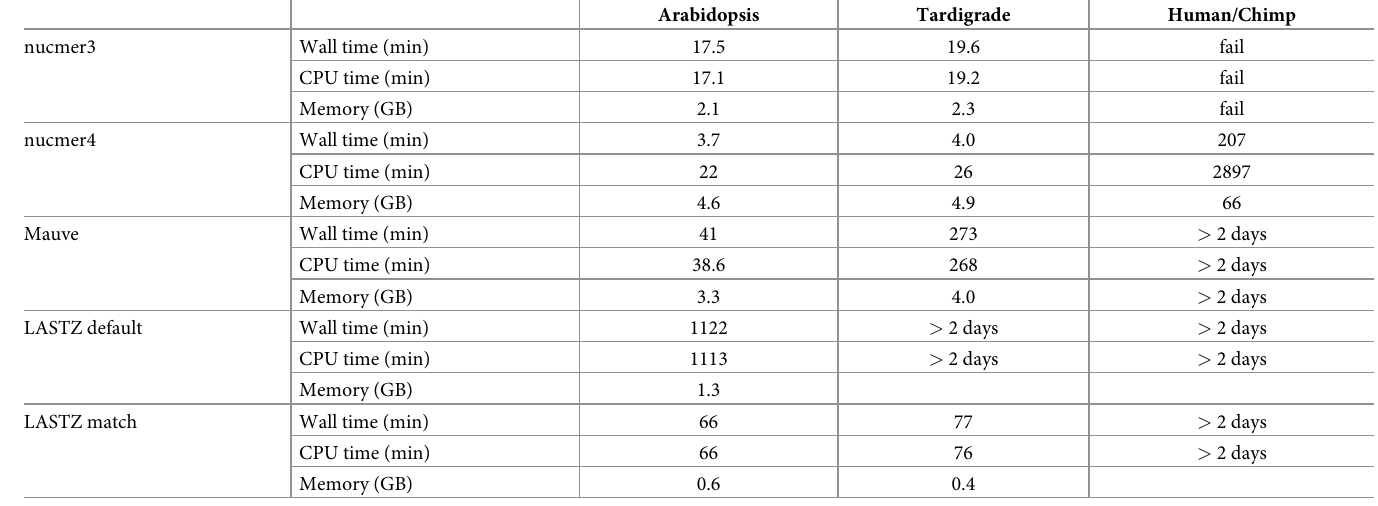
Table 3. Timing and memory usage to align two genome sequences for nucmer3 and nucmer4 compared to Mauve and Lastz aligners built using similar data struc- tures. We list both wall clock time and CPU time to show how effective is the code in utilizing multiple cores. Nucmer 4 is the fastest, but not the most memory efficient aligner. Nucmer3 failed to align human to chimp assembly due to the restriction on the size of the reference sequence. LASTZ and Mauve runs on human to chimp align- ments took over two days, and we stopped them after that. LASTZ defaults are optimized for high sensitivity, resulting in slow performance. Thus for fairness of timing comparisons we ran LASTZ twice: once with default settings and once with parameters that result in sensitivity matching that of nucmer4 with default settings. We list the parameters in the